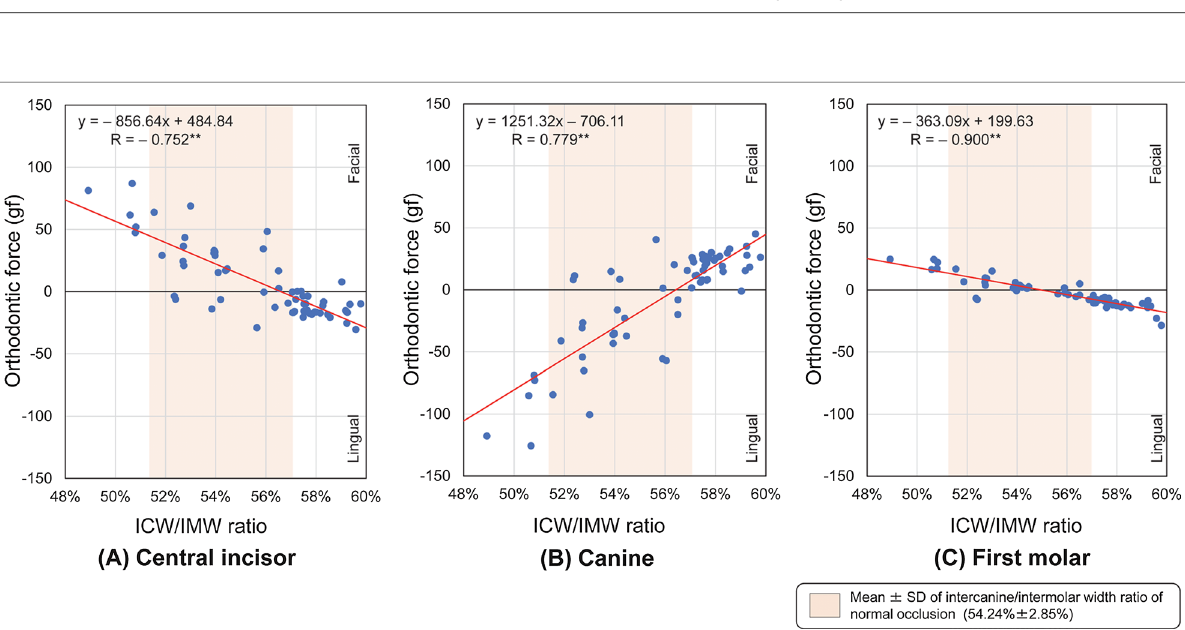
Fig. 5 Spearman correlation coefficients between the intermolar width (IMW) and orthodontic force delivered by 63 types of preformed archwires to the brackets at the A central incisors, B canines, and C first molars. ** P < .01 (Facial: positive, Lingual: negative)